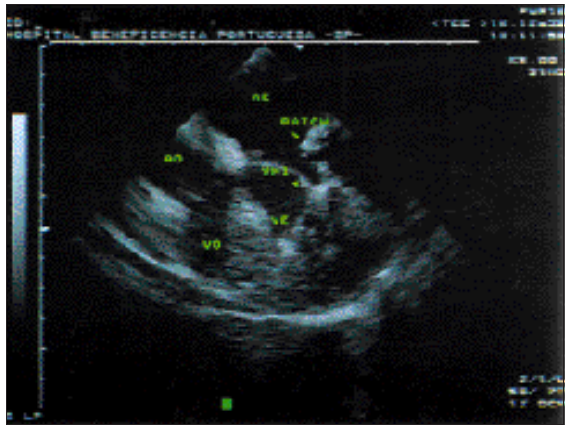
Fig. 8 – Ecocardiograma transesofágico intra-operatório. Corte trans- verso mostrando ausência de regurgitação mitral pós- plastia valvar.